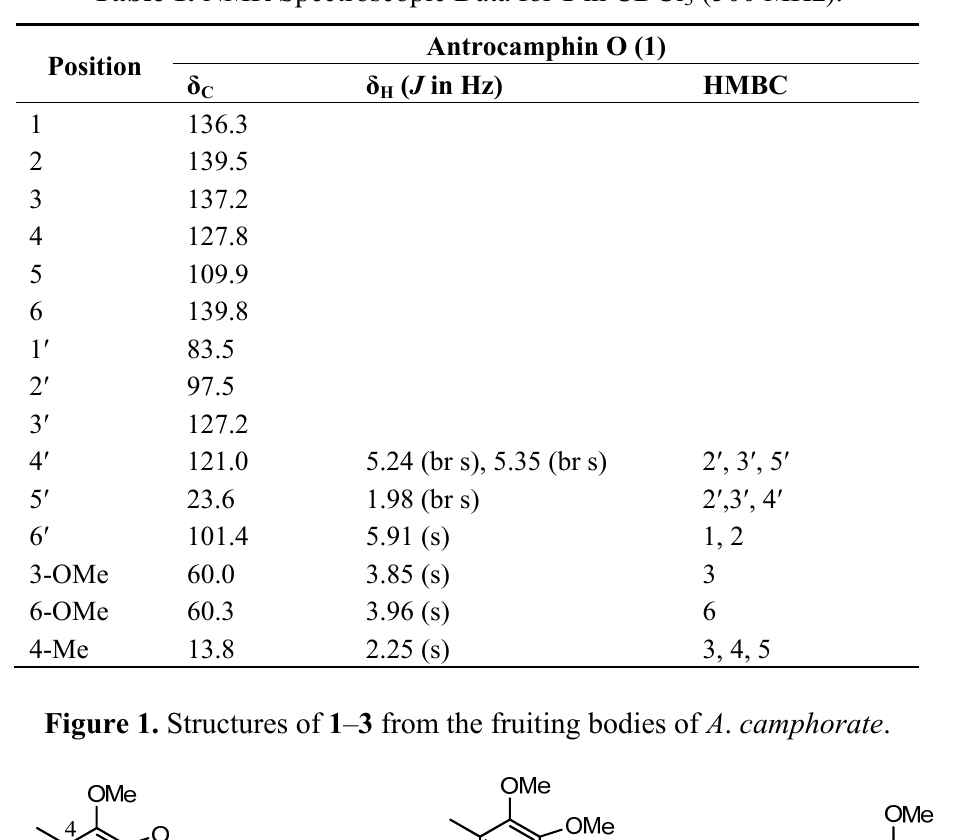
Table 1. NMR Spectroscopic Data for 1 in CDCl